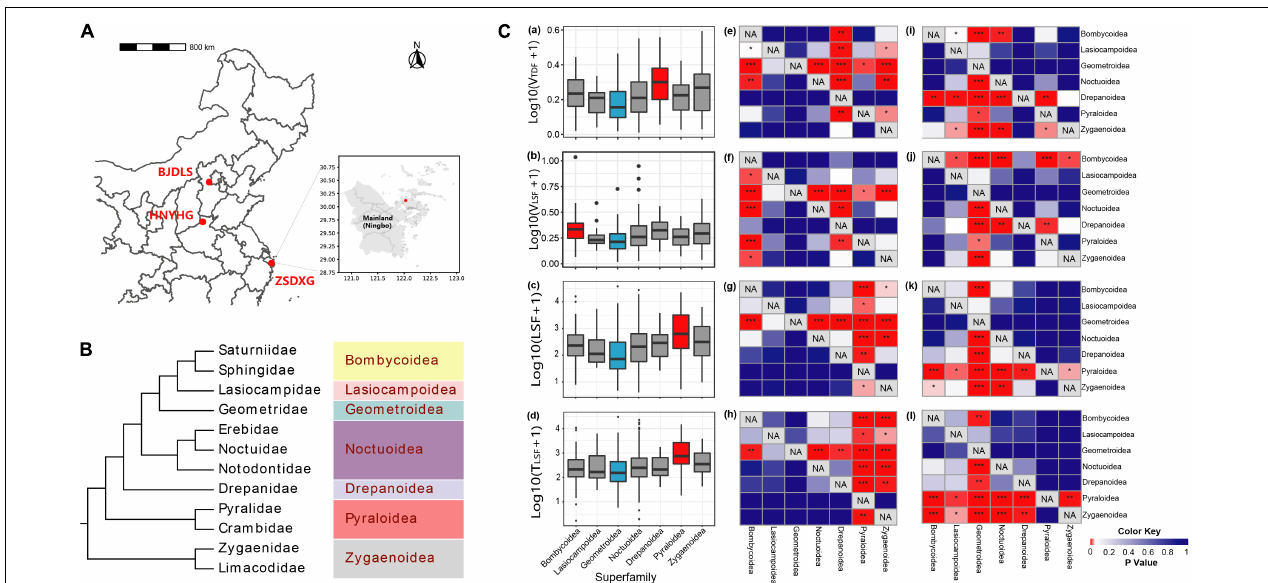
FIGURE 1 | Phylogenetic relationships above the family level and the differences of flight ability among the superfamilies were analyzed in this study. (A) Sample sites in this study. BJDLS, HNYHG, and ZSDXG samples were collected in 2017, 2018, and 2020, respectively; (B) the phylogenetic tree of all Lepidoptera samples in this study, redrawn according to Triant et al. (2018); (C) comparison of flight abilities among moths from different superfamilies and heat maps of p -value for Wilcoxon rank-sum test of the one-tailed hypothesis of the difference in flight ability between certain superfamilies (row) and other superfamilies (column). (Ca–d) The X -axis are indicators from all filtered data, and the Y -axis gives logarithmic conversion result of flight capabilities ( V TDF , V LSF , LSF , T LSF ), respectively. The color of the box represents the strength of the flight ability, red represents the strongest, blue represents the weakest, and gray represents the medium level. (Ce–h) P -value of Wilcoxon rank-sum test of the one-tailed hypothesis (less) (*:0.01 ≤ p < 0.05, **: 0.001 ≤ p < 0.01, ***: p < 0.001), respectively, the results corresponding to (Ca–d) . (Ci–l) P -value of Wilcoxon rank-sum test of the one-tailed hypothesis (greater) (*:0.01 ≤ p < 0.05, **: 0.001 ≤ p < 0.01, ***: p < 0.001), respectively, corresponding to (Ca–d)